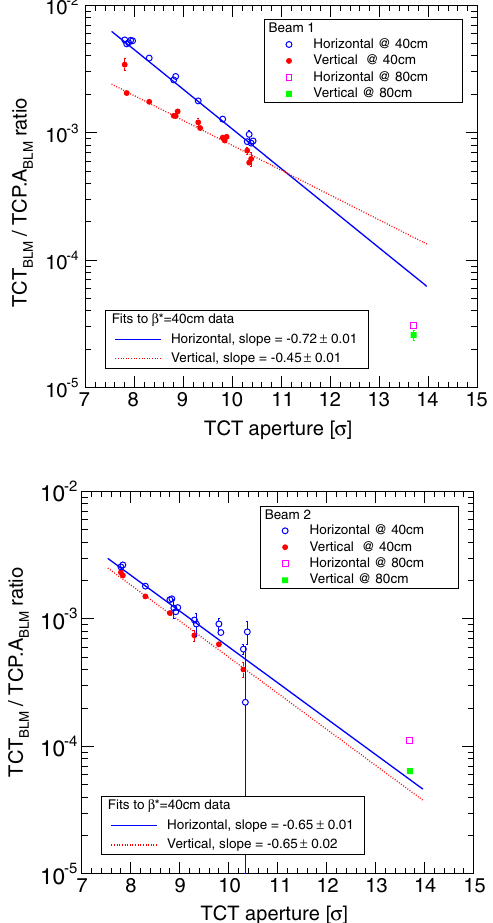
FIG. 4. Ratio of signals from the BLMs of the IR1 TCTs to the IR7 TCPs as a function of TCT opening for B1 (top) and B2 (bottom), combining the tests at β (cid:1) ¼ 40 cm and β (cid:1) ¼ 80 cm. For enhanced visibility, the points are slightly shifted with respect to each other to better separate the error bars. The fits do not take into account the β (cid:1) ¼ 80 cm data, i.e. the values at a TCT setting of 13 . 7 σ